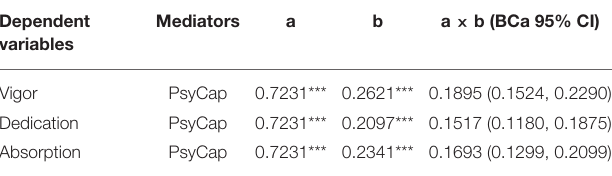
TABLE 4 | Mediating role of